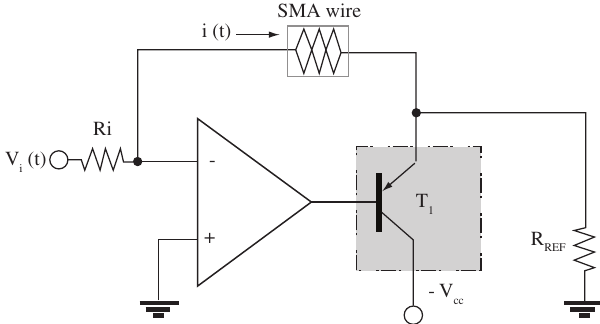
Figure 2. Electrical scheme of the voltage/current convert used to heat the SMA wire.